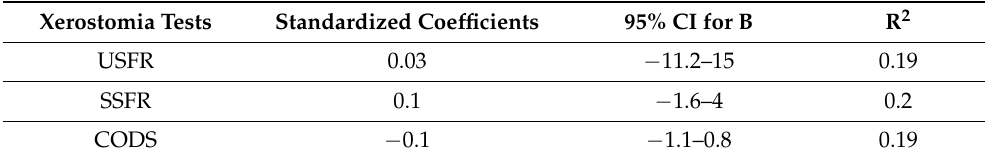
Table 3. Coefficients table for the multiregression analysis of the impact of xerostomia assessed by USFR, SSFR and CODS on the smell function of the pSS group.